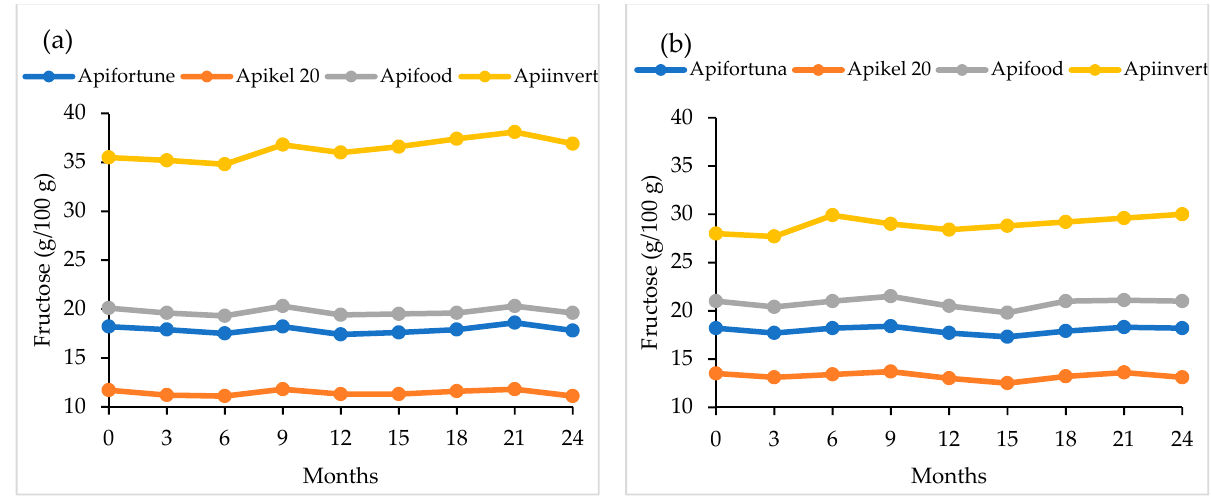
Figure 5. Changes of fructose content in syrups during storage at 10–14 °C ( a ) from 2012 and ( b ) from 2013.